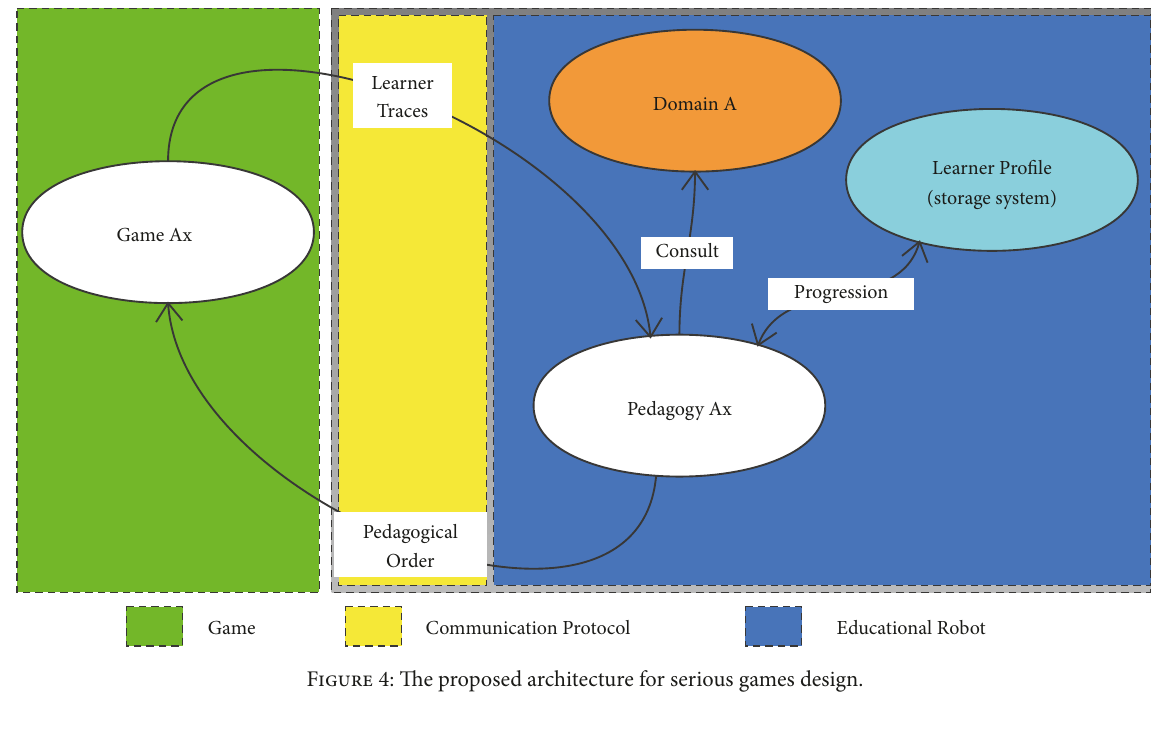
Figure 4: The proposed architecture for serious games design.